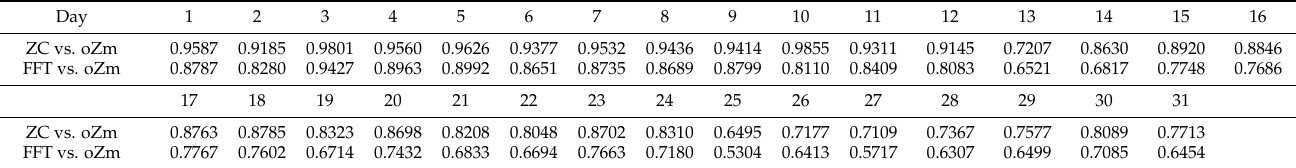
Figure 11. Maximum, minimum, and mean frequency per day. May 2021.